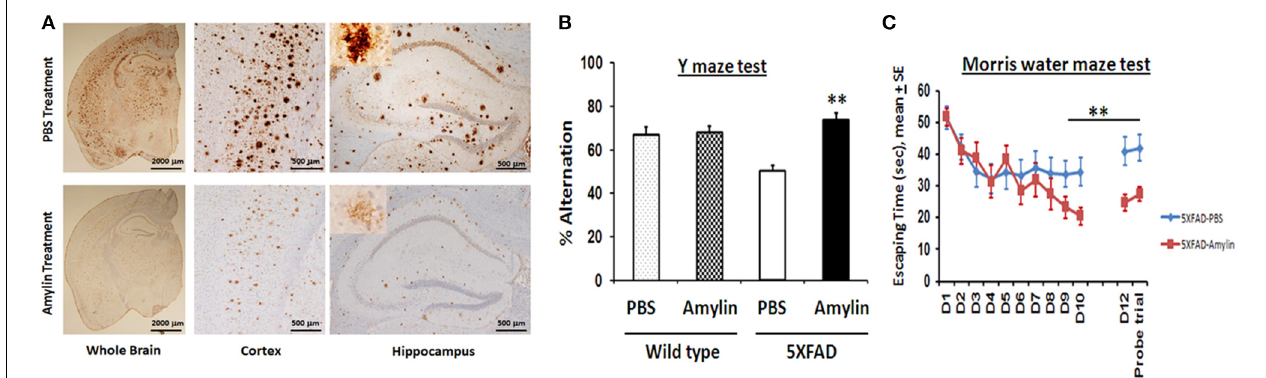
FIGURE 1 | Amylin treatment of 5XFAD mice reduces the amyloid burden and improves their learning and memory. At 3.5 months of age, 5XFAD mice were treated by i.p. injection of PBS or amylin (200pg/kg) daily for 10 weeks ( n = 10 per group). (A) Dense-cored A β plaque burden is reduced in the whole brain including the cerebral cortex and the hippocampus. The amylin treated 5XFAD mice illustrated